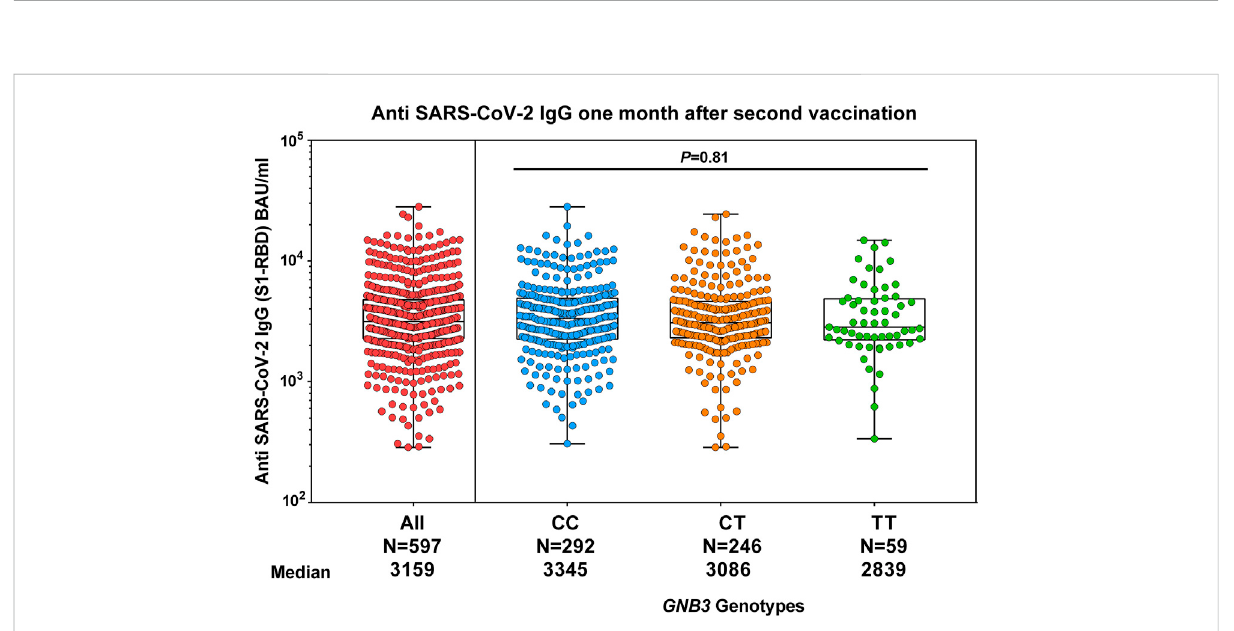
FIGURE 3 Comparison of humoral response and GNB3 genotypes 1 month after the second vaccination with mRNA-1273 in the replication group. The median of anti-spike antibody levels is given in BAU/ml.